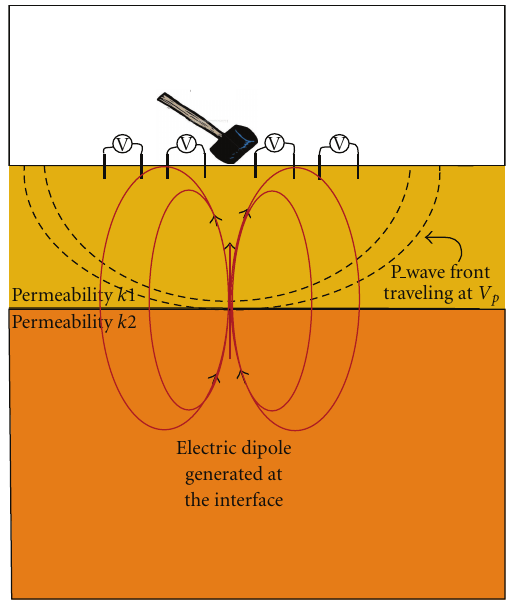
Figure 1: The seismic waves (induced by a hammer strike) pro- pagate up to the interface where an electric dipole is generated because of the contrast in permeability (or in other physical pro- perties). This electromagnetic wave can be detected at the surface by measuring the di ff erence of the electrical potential V between electrodes. Picking the time arrival allows to know the depth of the interface.